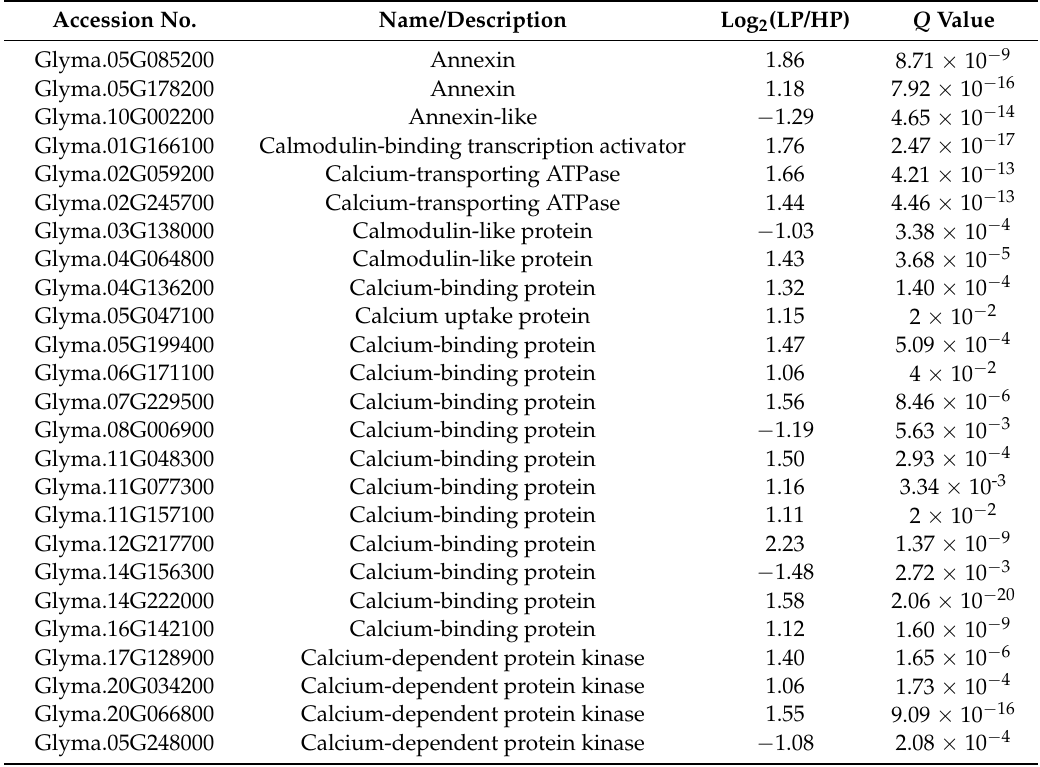
Table 5. Differentially expressed genes involved in Ca 2+ signaling.